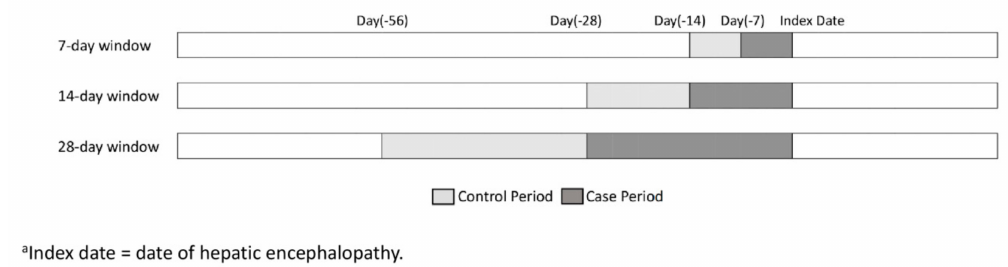
Figure 1. Illustration of case-crossover design to evaluate hepatic encephalopathy risk after short-term proton pump inhibitor (PPI)